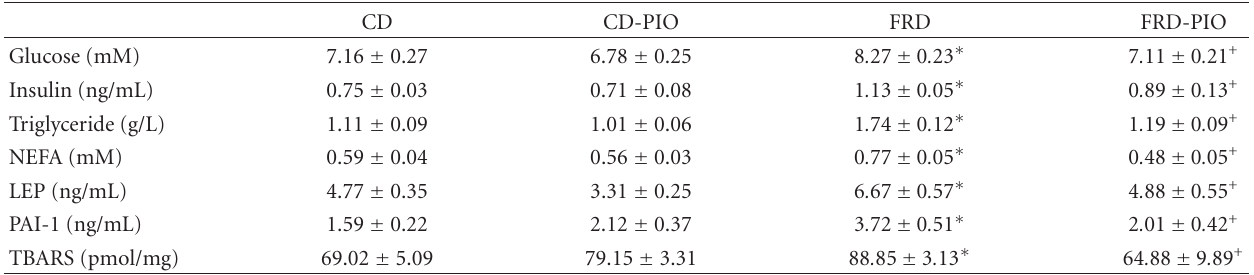
Table 2: Circulating levels of several markers of the adipoinsular axis function and TBARS. CD CD-PIO FRD FRD-PIO Glucose